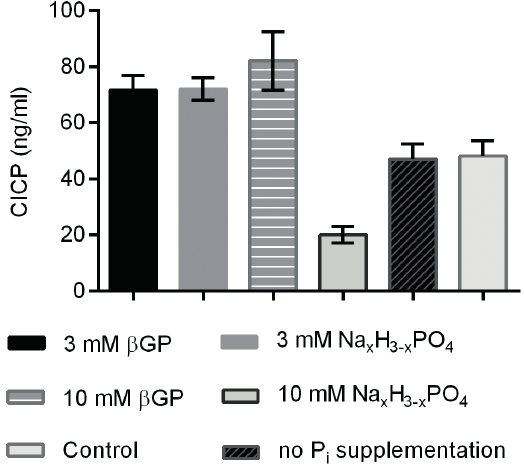
Figure 7. Rate of collagen synthesis. CICP assay of the supernatant during osteogenic induction. Data are mean of days 14 and 21 6 SD for n=4 donors.